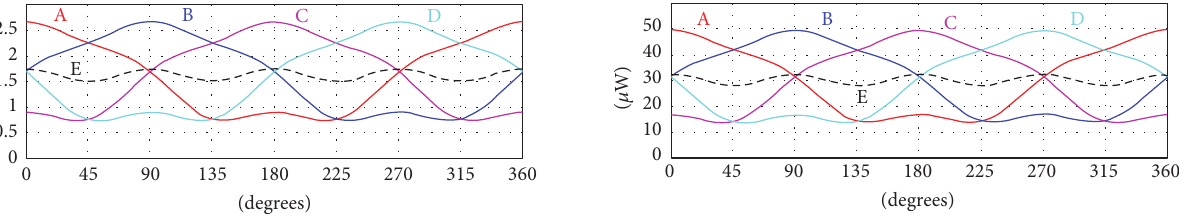
Figure 13: Radiation patterns of the user ports, at 800MHz, in the plane 𝜃 = 𝜋/2 , versus the azimuth angle 𝜑 : the pattern of user port 1 is curve A; the pattern of user port 2 is curve B; the pattern of user port 3 is curve C; the pattern of user port 4 is curve D; and the average of curves A to D is curve E.